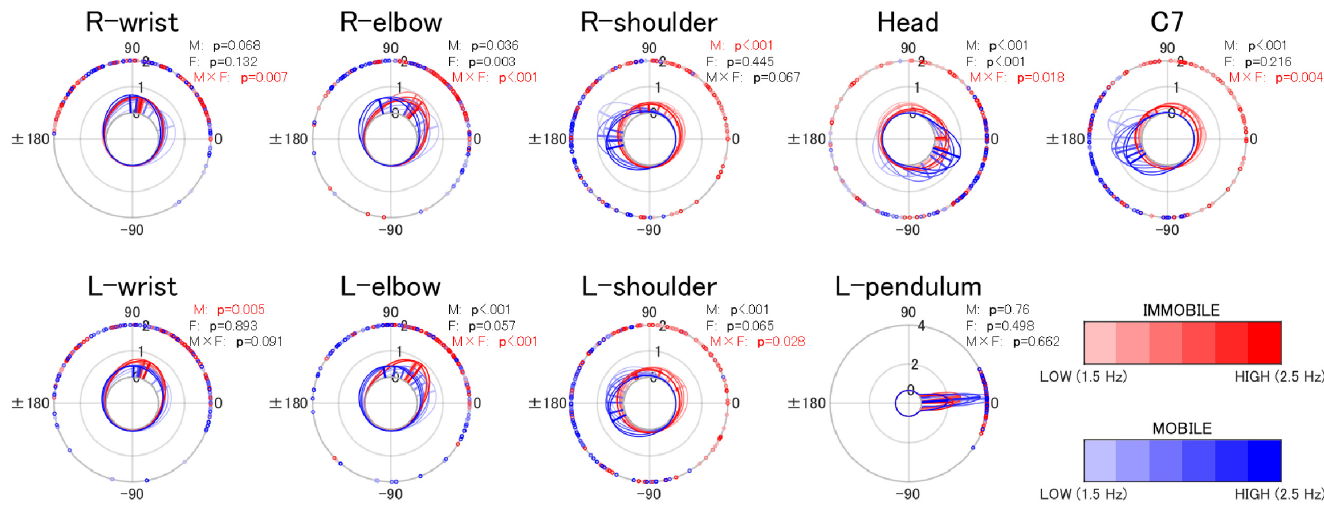
Fig 6. Phase difference between the pendulum and body parts (in-phase) ( N =18). This shows the relative phase between the anterior-posterior motion of the pendulum and each body part ( N =18) by mobility (immobile vs. mobile) in color temperature (warm vs. cold) and frequency as color gradient. All data of the 18 participants are shown in the outer circle. Two things are shown on the inner circle: the mean vector (straight line) of the data of all participants, of which the length corresponds to the angle concentration κ , and the probability density function (von Mises distribution) calculated based on the mean vector and concentration κ . Results of the two-way Harrison-Kanji test are shown on the upper right of each panel.